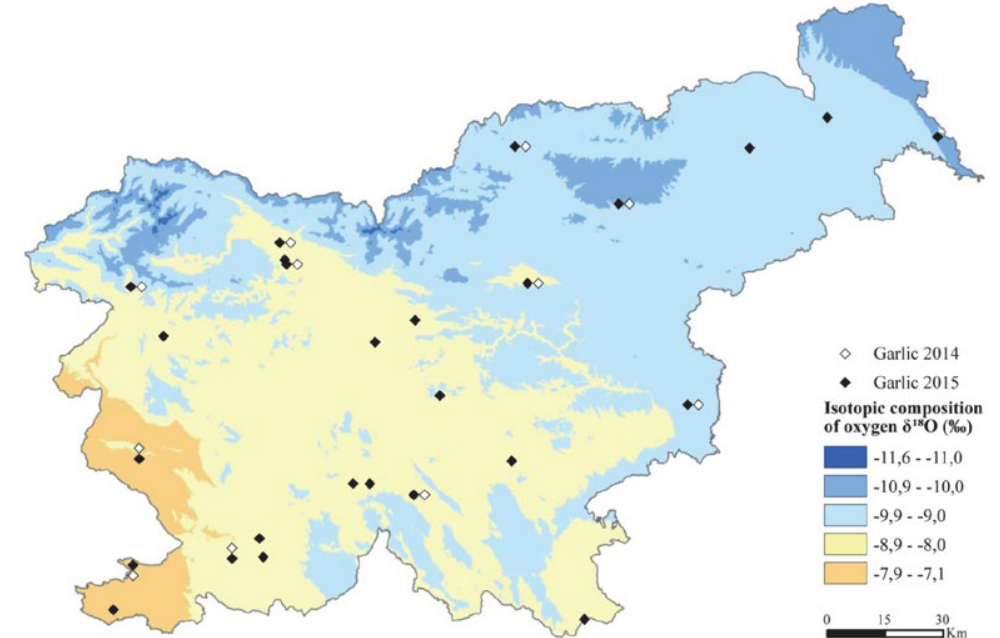
Fig. 2. Assessment of isotopic composition of δ 18 O in groundwater in Slovenia (multiple linear regression method) 30 and sample sites for garlic